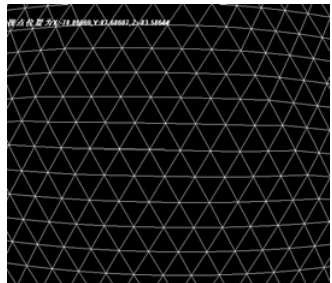
Figure 7 the effect of zoom in area